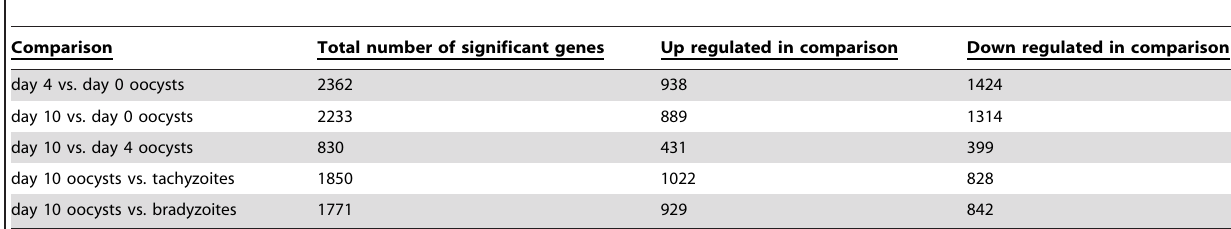
Table 2. Summary of numbers of genes with significantly differing levels of gene expression in pair-wise comparisons of oocyst maturation time points and between mature day 10 oocysts and tachyzoites and bradyzoites.